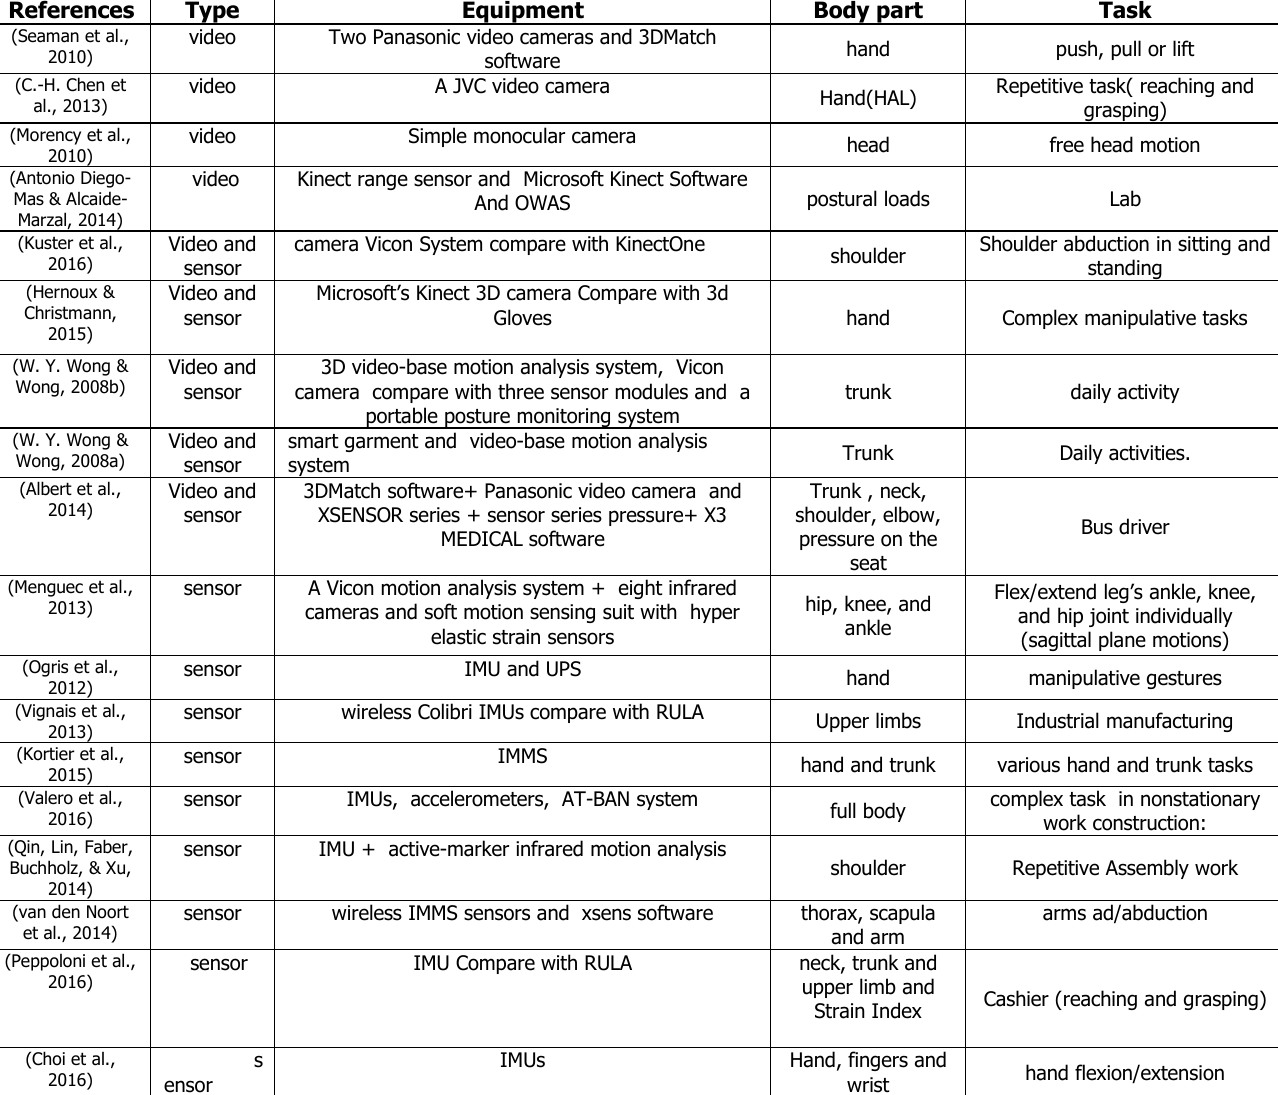
Table1: Methodological summary of